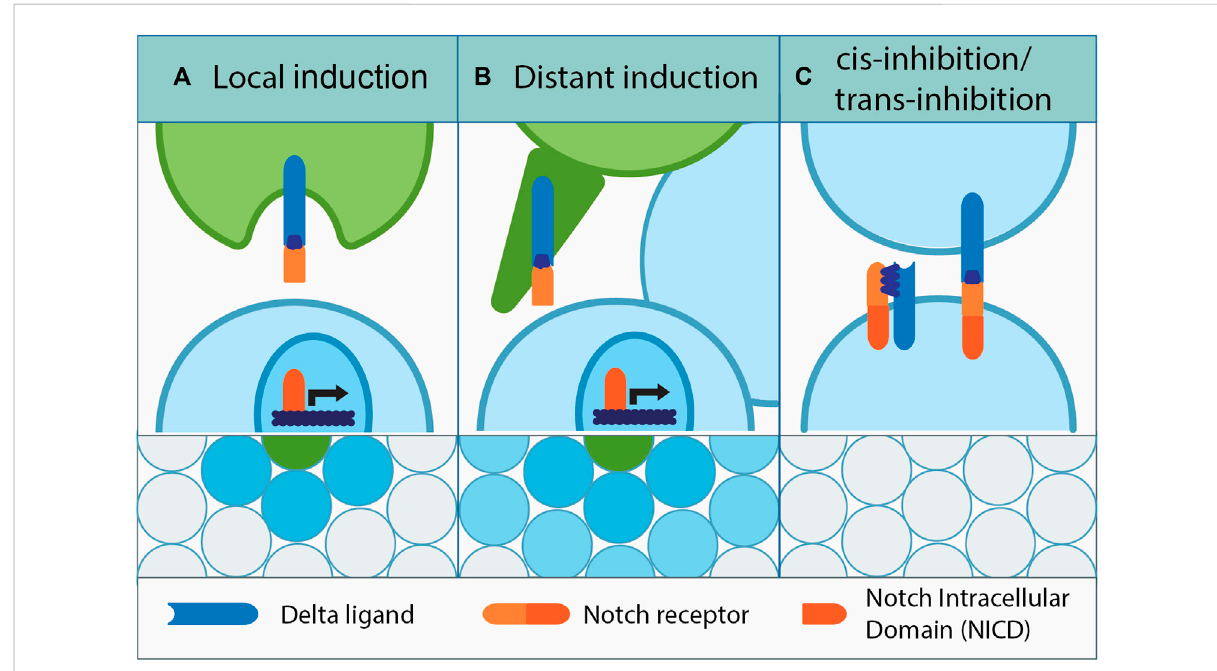
FIGURE 1 Dialects of Notch. (A) Among equipotent adjacent cells, a signal-sending cell induces Notch signaling in its neighbors through “ lateral inhibition. ” The same principle among non-equipotent cells is called “ local induction. ” Upon binding to the Delta ligand, the cleaved NICD domain of the Notch receptor travelstothenucleusandactivatesNotch-dependentgeneexpression. (B) Deltasignalcanalsobesentfurtherawaybyusingcellprojections,whichestablish direct contact with the target signal-receiving cell. This mechanism called “ distant induction, ” and it facilitates cell communication and Notch- dependentcellfateinductionacrossseveralcelldiameters. (C) Notchsignalinginhibitioncanbeintrinsicorextrinsic; cis- inhibitionoccursbetweentheDelta ligandandNotchreceptorpresentonthesamecell, while trans- inhibitionoccursbetweenadjacentcellsthatform theDelta – Notchcomplex, whichfailto trigger Notch cleavage due to improper Delta processing or lack of suf fi cient membrane driven